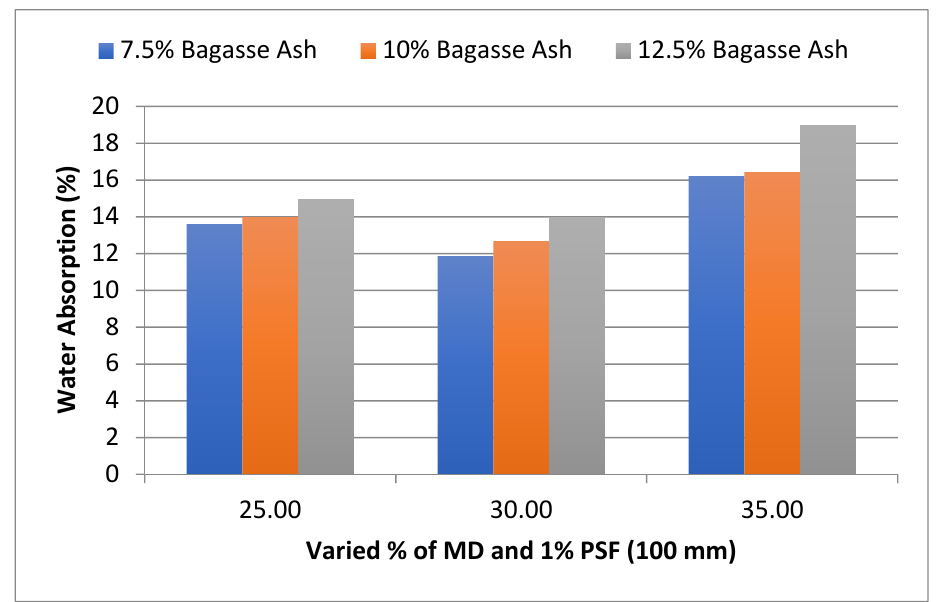
Figure 6. Effect of MD and BA on water absorption of block reinforced with 1% PS fiber (100 mm).